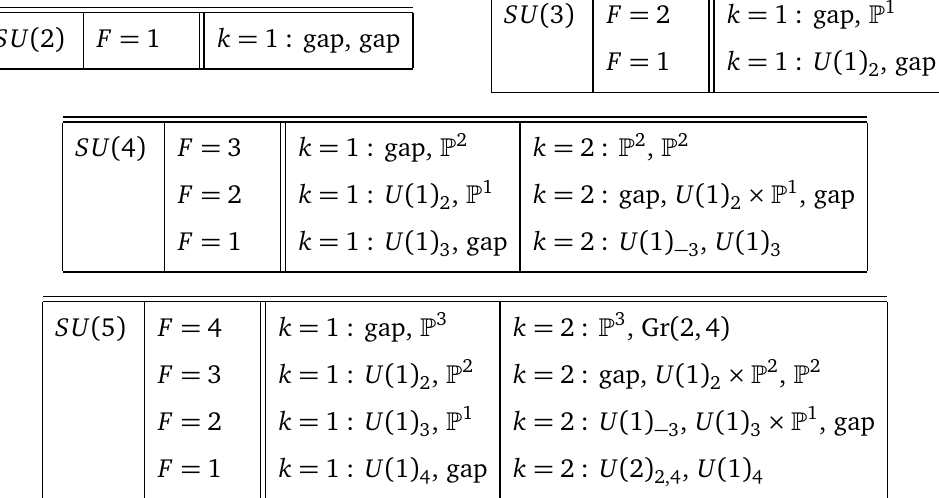
Table 2: List of all BPS domain walls of massive SU ( N ) SQCD with F < N , for (cid:28) Λ , up to rank N = 5 (extracted from Table 1). We only indicate k -walls m 4d with k ≤ N / 2, since the remaining ones with N / 2 < k < N are obtained applying on different domain walls (for topological sectors we use here the